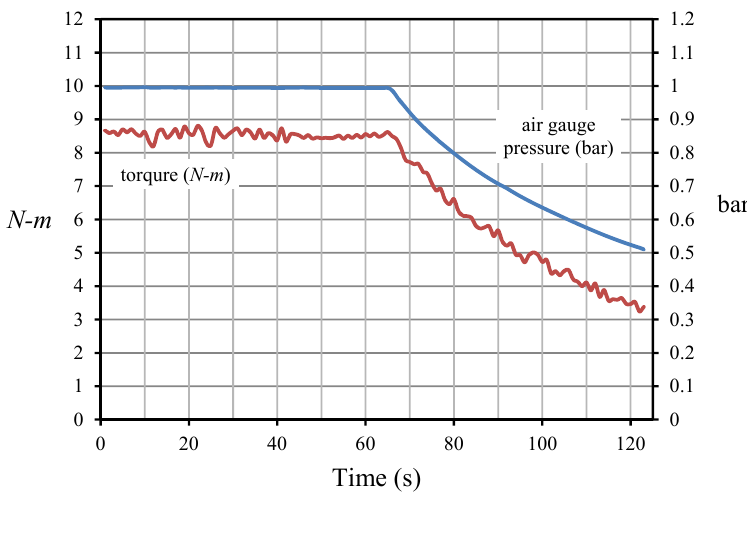
Figure 16. The air pressure and output torque changes during one phase at 200 rpm.